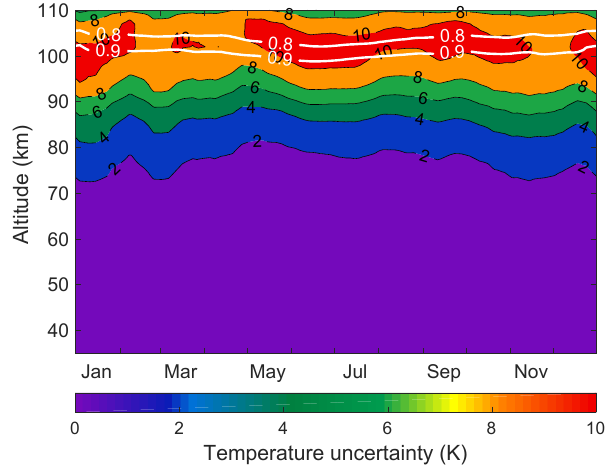
Figure 6. Statistical temperature uncertainty of the temperature cli- matology. The white lines are the height below which the tempera- ture climatology is more than 90% (0.9) and 80% (0.8) due to the